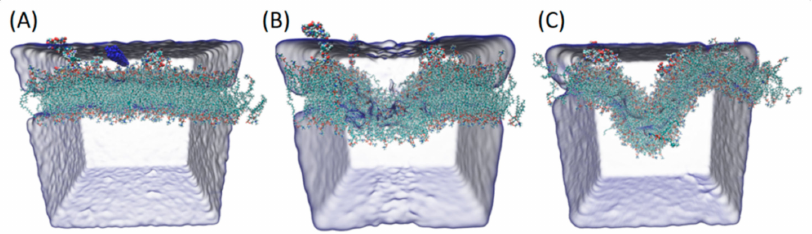
Figure 4. Snapshots of POPC system with incorporated A β peptides throughout pressure wave propagation. In panel ( A ) water particles with increased velocity are marked blue. In panel ( B ) a snapshot of system after 13 ps is presented. In panel ( C ) a final snapshot of simulation after 3 ns is presented.